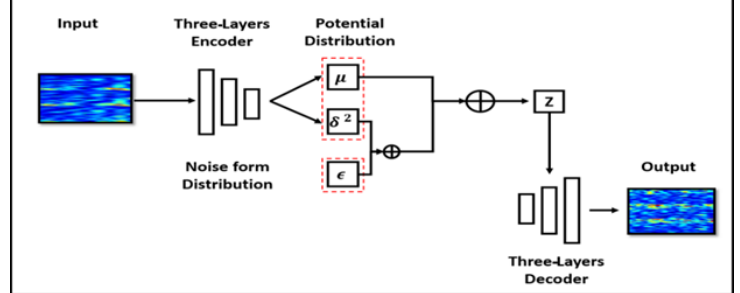
Figure 7. Data augmentation using a variational autoencoder.